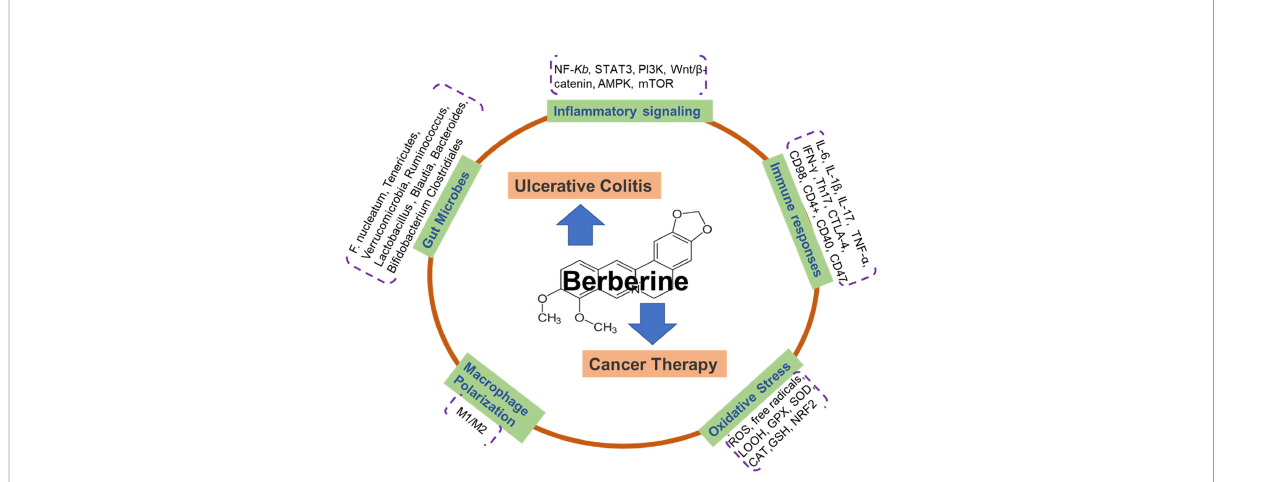
FIGURE 1 Schematic illustration depicting that berberine actions on ulcerative colitis and cancer therapy via multiple mechanisms. Berberine is an isoquinoline alkaloid puri fi ed from Chinese herbs and a naturally occurring compound extracted from Coptidis Rhizoma. There are 5 potential functions of BBR on the treatment of ulcerative colitis and cancer, including: in fl ammatory signaling pathways (NF- k B, STAT3, PI3K, Wnt/ b - catenin, AMPK, mTOR); gut microbes ( F. nucleatum , Tenericutes , Verrucomicrobia , Ruminococcus , Lactobacillus , Blautia , Bacteroides , Bi fi dobacterium , Clostridiales) ; immune responses (IL-6, IL-1 b , IL-17, TNF- a , IFN- g , Th17, CTLA-4, CD98, CD4+, CD40, CD47); macrophage polarization; Oxidative Stress (ROS, free radicals, LOOH, GPX, SOD, CAT, GSH,